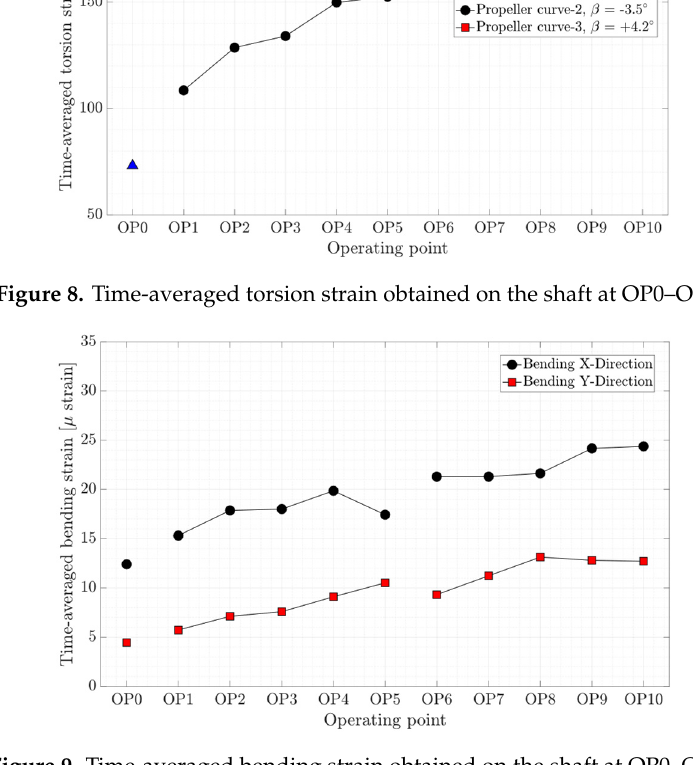
Figure 9. Time-averaged bending strain obtained on the shaft at OP0–OP10.